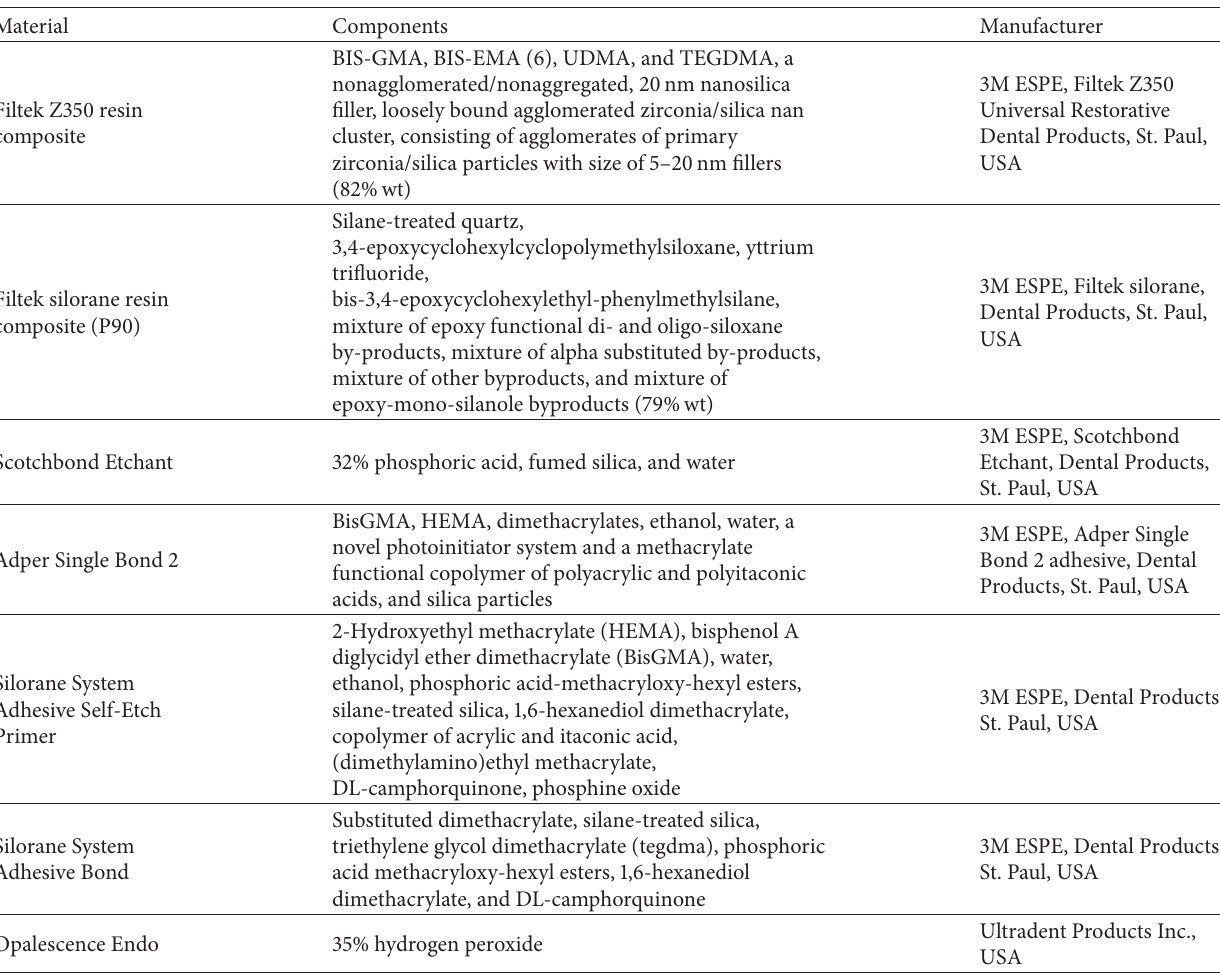
Table 1: Materials, chemical compositions, and manufacturer used in the